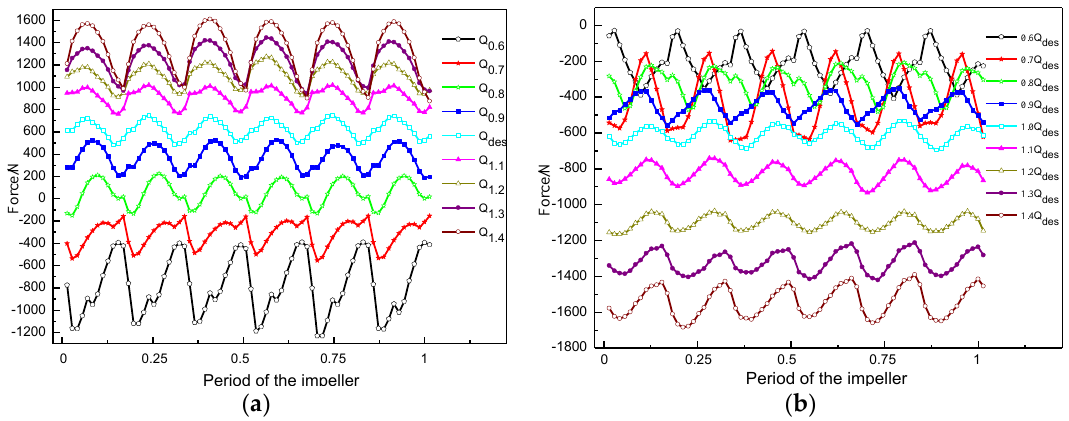
Figure 14. Hydraulic radial force versus time under different flow conditions: ( a ) X direction; ( b ) Y direction.